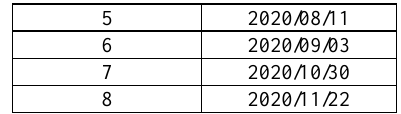
Table 1. Used Landsat-8 multi-temporal images.